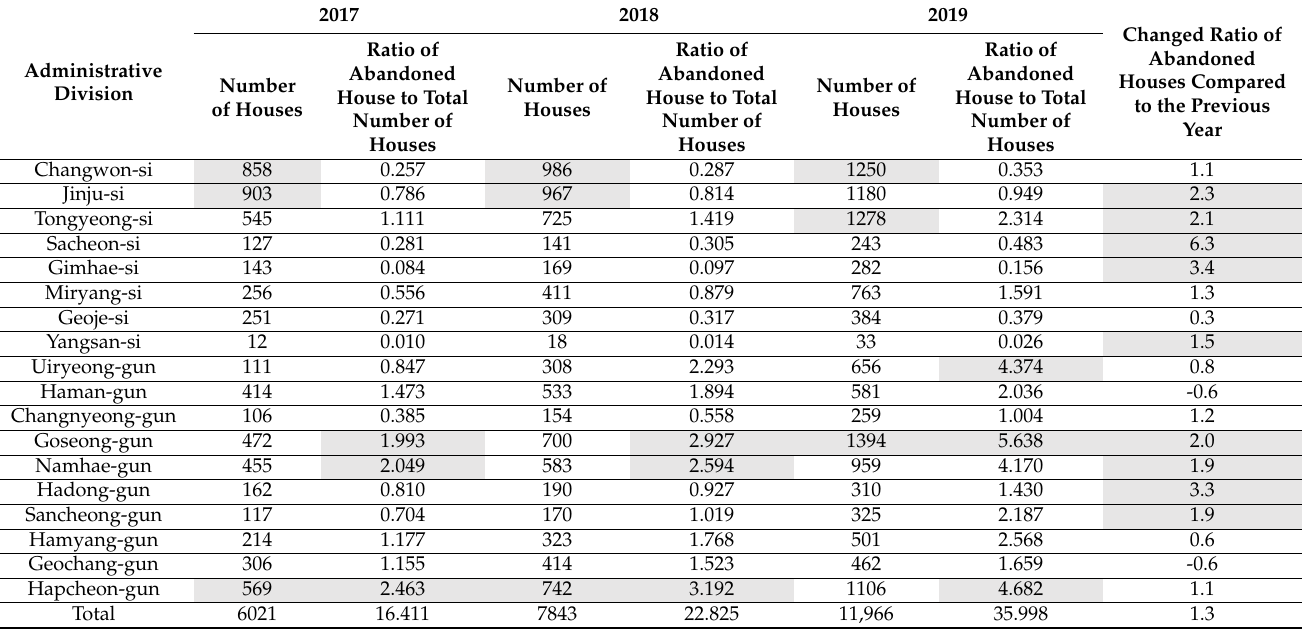
Table 1. Abandoned houses in Gyeongsangnam-do.